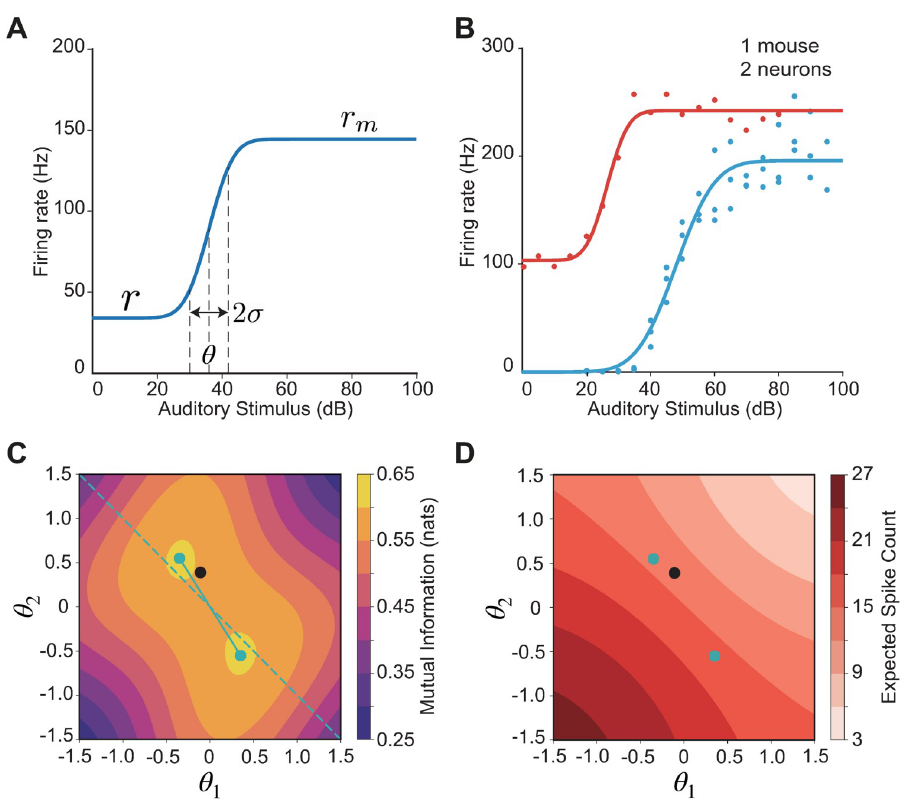
Fig 7. The tuning of auditory nerve fibers (ANFs) match predictions from optimal coding. A . The sigmoidal function that we use to fit ANFs tuning curves. Spontaneous firing rate ( r ), maximal firing rate ( r ( θ ), and the dynamic range ( σ ) are labelled on the curve. B . An example showing original data from ref. [8] and fitted tuning curves. These two tuning curves come from the same mouse. C . Optimal configuration (cyan dots) in the contour plot of mutual information. Black dot denotes the fitted thresholds from the data. D . Optimal configuration (cyan dots) in the contour plot of average firing rate. Black dot denotes the fitted thresholds from the